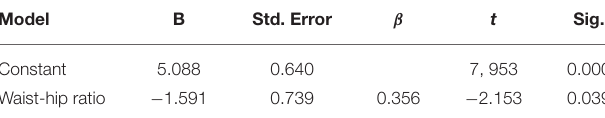
TABLE 3 | Regression estimation 1.